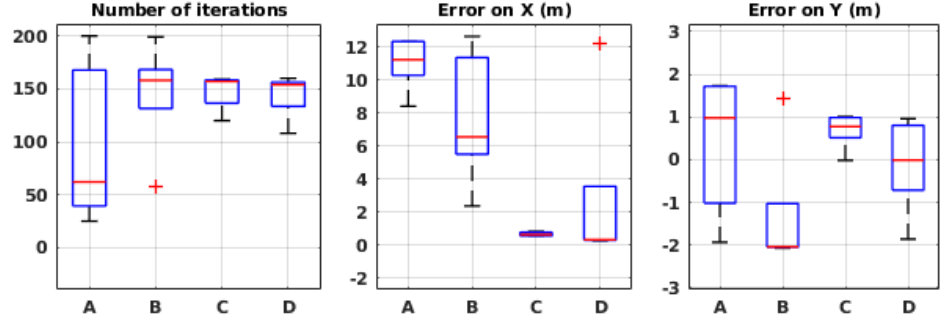
Figure 14. Evaluation results in wind tunnel experiments for different environmental conditions in the local framework. See Table 1 for the meaning of the